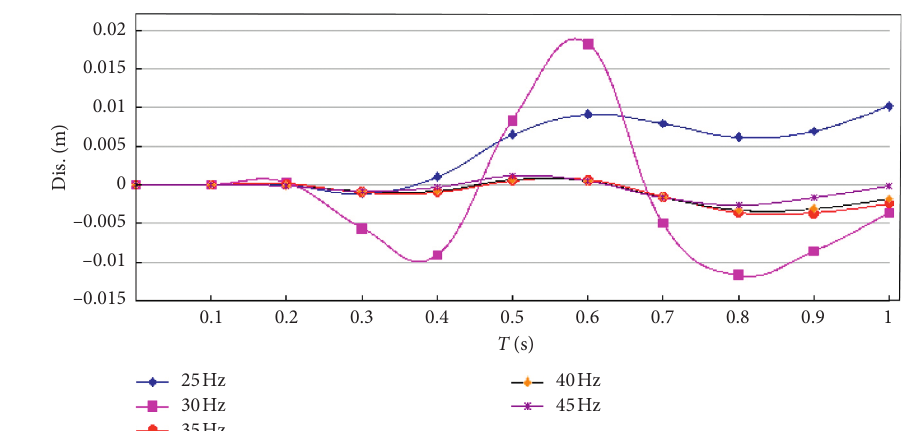
Figure 14: Variations of slope displacement during blasting.